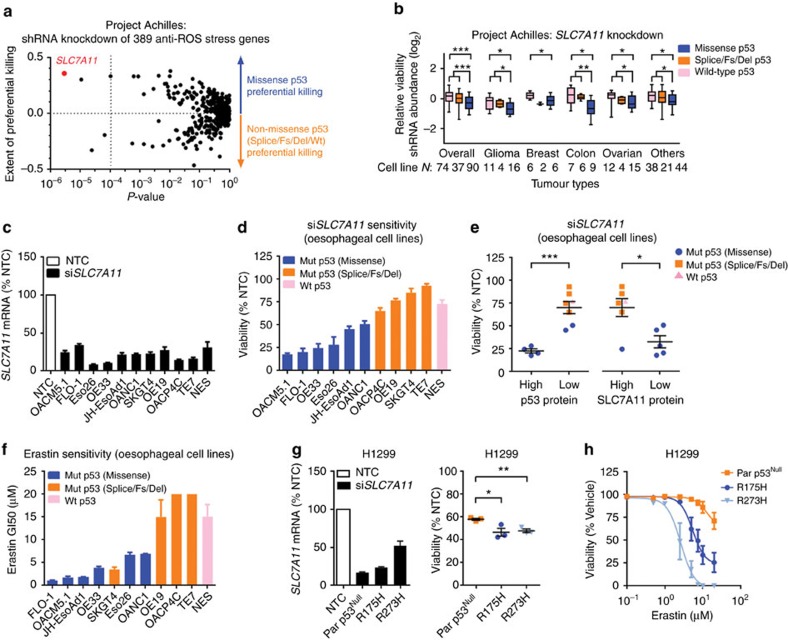
System xC− inhibition selectively targets cancer cells with mut-p53 accumulation.(a) Plot of 389 anti-ROS stress genes identified in an unbiased multi-omics analysis of the Broad Institute's Project Achilles v2.4 dataset (See Methods and Supplementary Fig. 9 for analysis workflow), correlating statistical significance with cancer cell killing following shRNA-mediated gene knockdown. Vertical axis quantifies the extent of preferential killing of missense mut-p53 cells (which typically accumulate mut-p53 protein) versus non-missense p53 cells (including wt-p53, splice, frameshift (Fs) and deletion (Del) variants). Vertical dotted line: Bonferroni corrected P-value=1.1 × 10−4 comparing the effect of gene knockdown on missense mut-p53 versus non-missense p53 cancer cells. See also Supplementary Data 1. (b) Cell viability following shRNA-mediated knockdown of SLC7A11 in cell lines from Project Achilles v2.4. Each box/whiskers plot=median/5–95 percentiles. (c) SLC7A11 mRNA levels 48 h post transfection with non-targeting control (NTC) siRNA or siSLC7A11 in oesophageal cell lines. (d,e) Viability at 96 h post SLC7A11 knockdown (d) and grouped by each cell line's endogenous p53 (e, left) or SLC7A11 (e, right) protein expression. (f) Erastin sensitivity (GI50) in oesophageal cell lines. (g) SLC7A11 knockdown in parental (Par) p53Null and mut-p53 overexpressing H1299 cells. SLC7A11 mRNA (left) and viability (right) was measured at 48 and 96 h post siRNA transfection, respectively. (h) Viability at 96 h post erastin treatment in p53Null and mut-p53 overexpressing H1299 cells. For all studies n=3 except (h) n=5, and (a,b). Unpaired t-test (b,e), one-way ANOVA with Dunnett's multiple comparison post-test (g). Error bars=s.e.m., *P<0.05, **P<0.01, ***P<0.01. See also Supplementary Fig. 6.